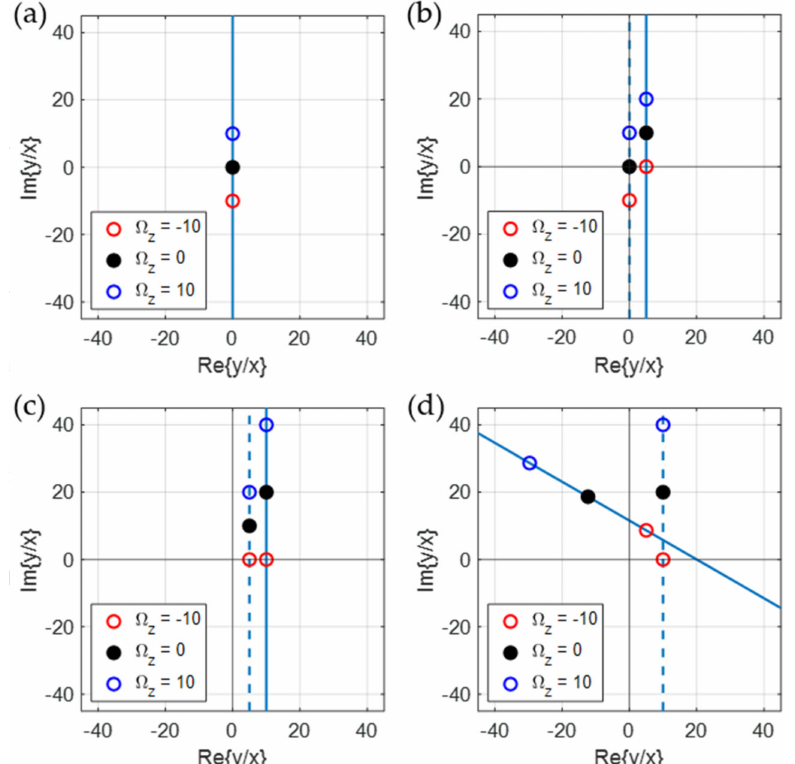
Figure 3. The trace of the ratio y/x in Equation (16) simulated with various resonator parameters and drawn in a complex plane. The trace is plotted when B , θ , a , and b are ( a ) 1, 0 ◦ , 0, and 0; ( b ) 1, 0 ◦ , 10, and 5; ( c ) 2, 0 ◦ , 10, and 5; ( d ) 2, 60 ◦ , 10, and 5, respectively. The trace is always on a straight line and the line is determined by the four real constants B , θ , a , and b of Equation (16). The dotted line is the trace made with just the previous